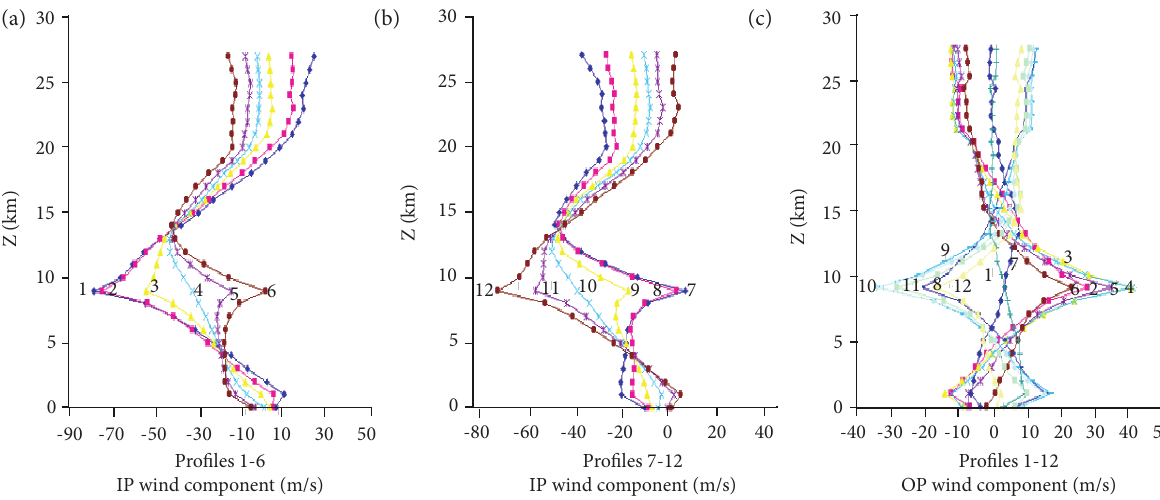
Figure 1. KSC’s worst month (February) VWP model design wind component profiles for (a) IP profiles 1–6, (b) IP profiles 7–12, and (c) OP profiles 1–12 (reference height = 9 km (5 nmi)), IP and OP wind components in m/s, for flight azimuth = 90° (graphical presentation of the same information given in Table 2)). Johnson